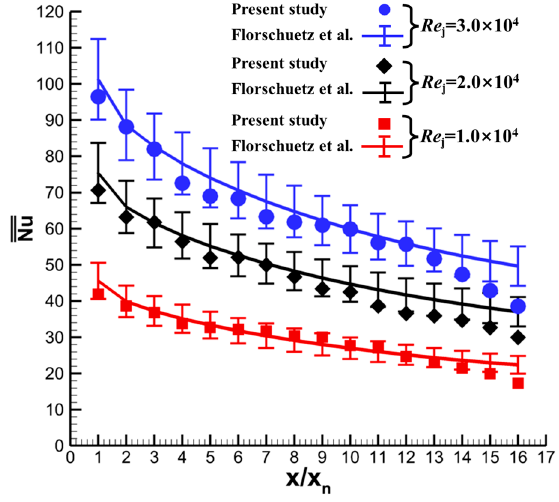
Figure 4. Row-averaged Nu from measurements and correlation of Florschuetz et al. [35].